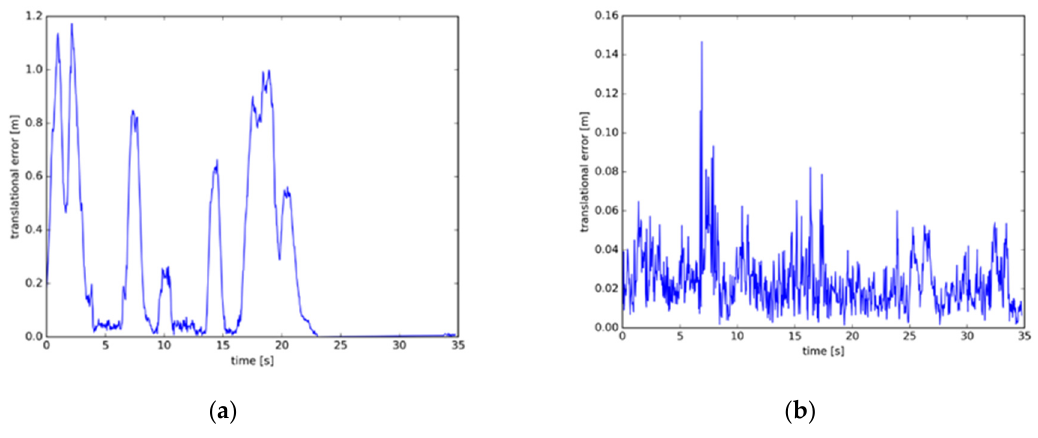
Figure 11. Relative pose error of dataset one: ( a ) The relative pose error of dataset one using ORB- SLAM2; ( b ) The relative pose error of dataset one using instance SLAM based on CO-HDC.